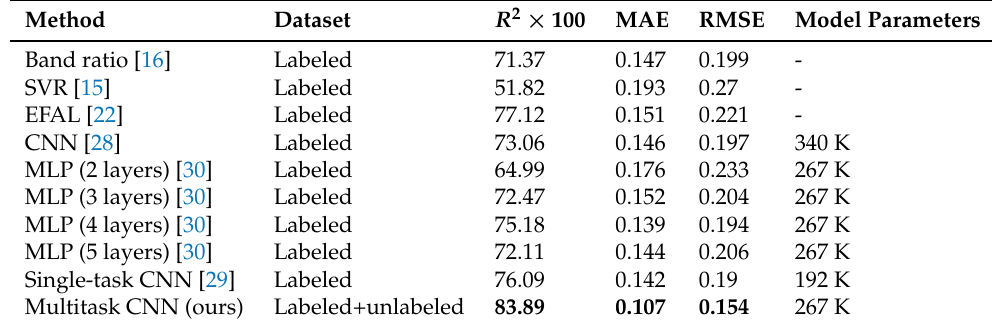
Table 2. Mean Chl-a estimation results across 10 folds of cross-validation with the best results in bold, where R 2 , MAE, and RMSE denote the coefficient of determination, mean absolute error, and root mean square error, respectively.